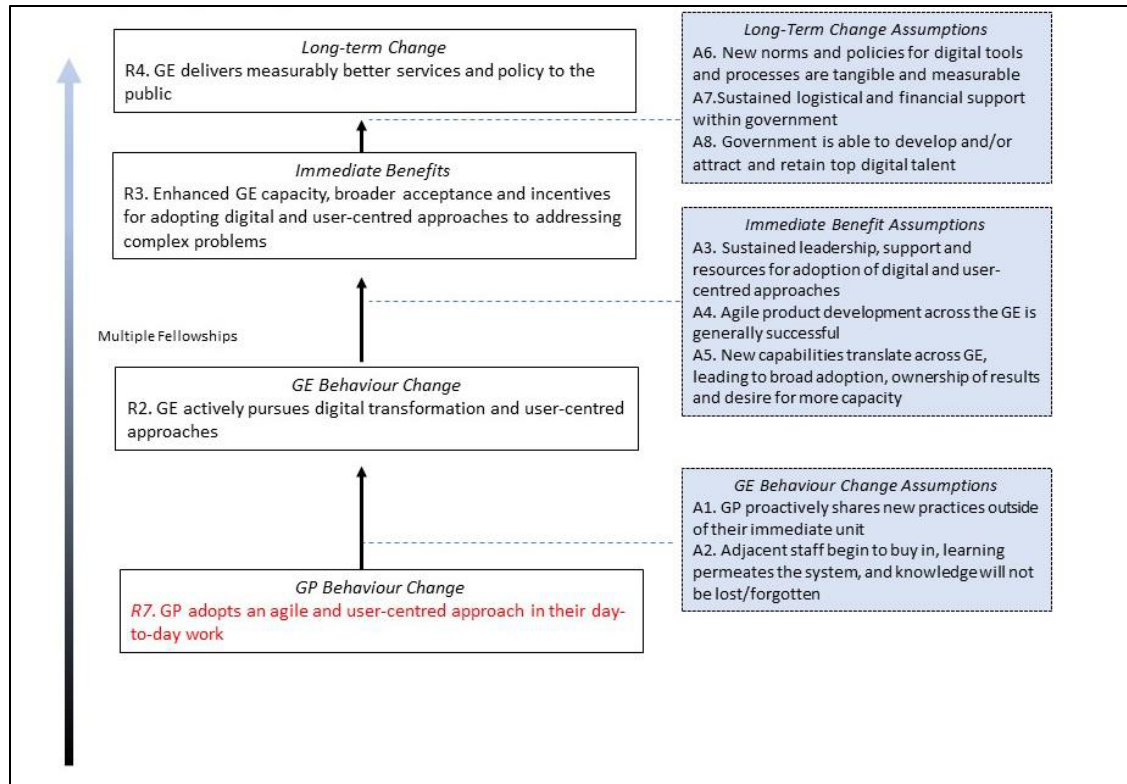
Figure 6: Code for Canada Fellowship Theory of Change Story 3 (Long-term digital transformation in GE) The stories within the ToC serve as a foundation for developing a monitoring and evaluation plan. Specifically, it ensures that all partners have a basic understanding of the goals for the Fellow- ship and what their respective responsibilities are. Discussions between the stakeholders can illumi- nate what data is high-priority and what, conditions should be closely monitored